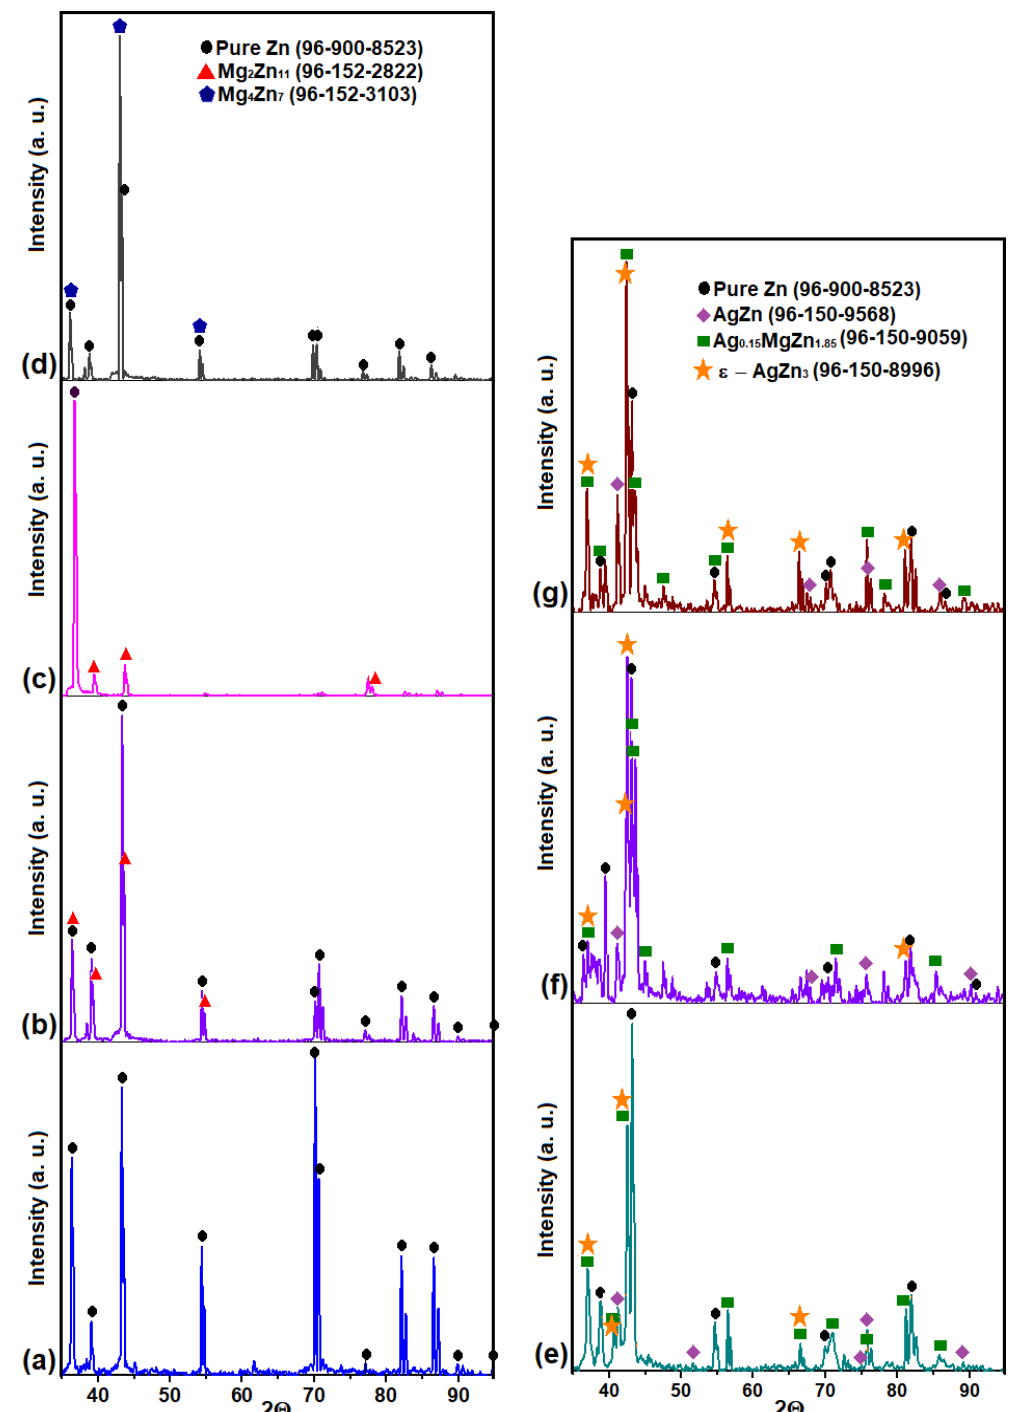
Figure 8. XRD diffraction patterns showing processing phase evolution of the Zn-based alloys: ( a ) pure Zn as-extruded at 280 °C; ( b ) Zn-1Mg as-cast; ( c ) Zn-1Mg ST for 5 h at 370 °C; ( d ) Zn-1Mg as-extruded at 280 °C; ( e ) Zn-12.5Ag-1Mg as-cast; ( f ) Zn-12.5Ag-1Mg ST for 5 h at 370 °C; ( g ) Zn-12.5Ag- 1Mg as-extruded at 280 °C.